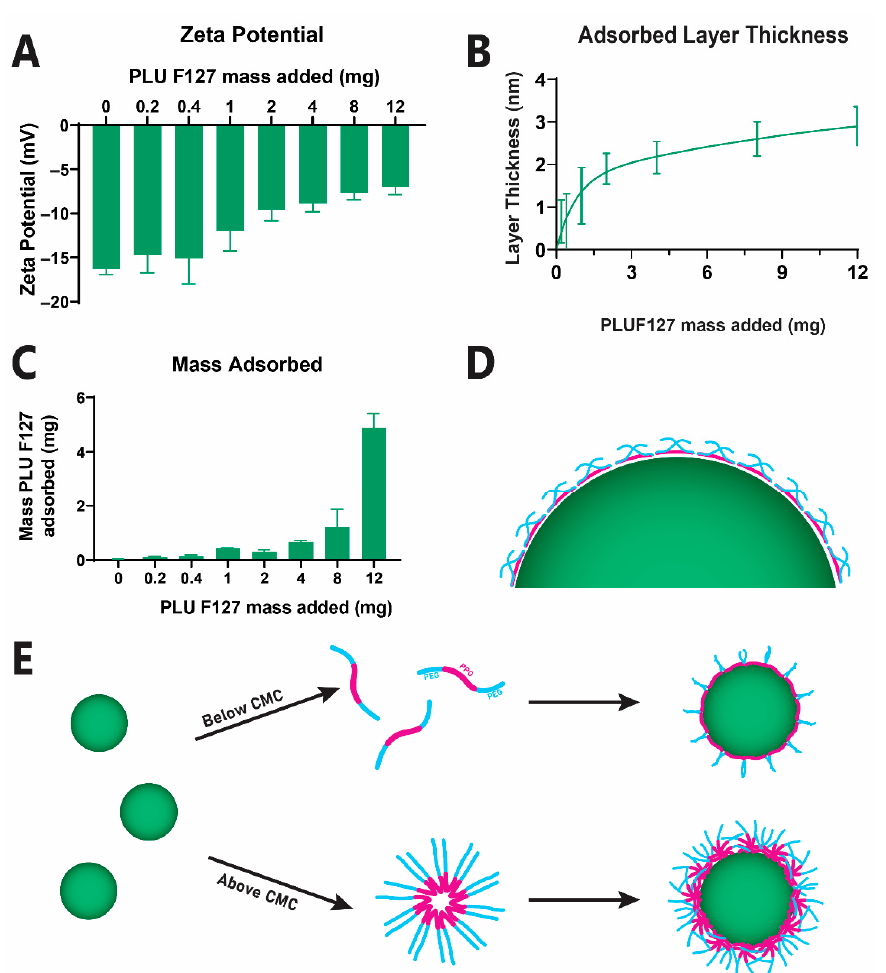
Figure 1. PLUF127 coating of anionic PLGA nanoparticles to provide a physically adsorbed PEG coating layer ( A ) Change in zeta potential following incubation of anionic PLGA nanoparticles with PLUF127 associated with layer thickness ( B ) and resultant mass PLUF127 adsorbed ( C ). Schematic representation of PLUF127 PEG chain extension on the nanoparticle surface ( D ) and mechanism of adsorption ( E ).